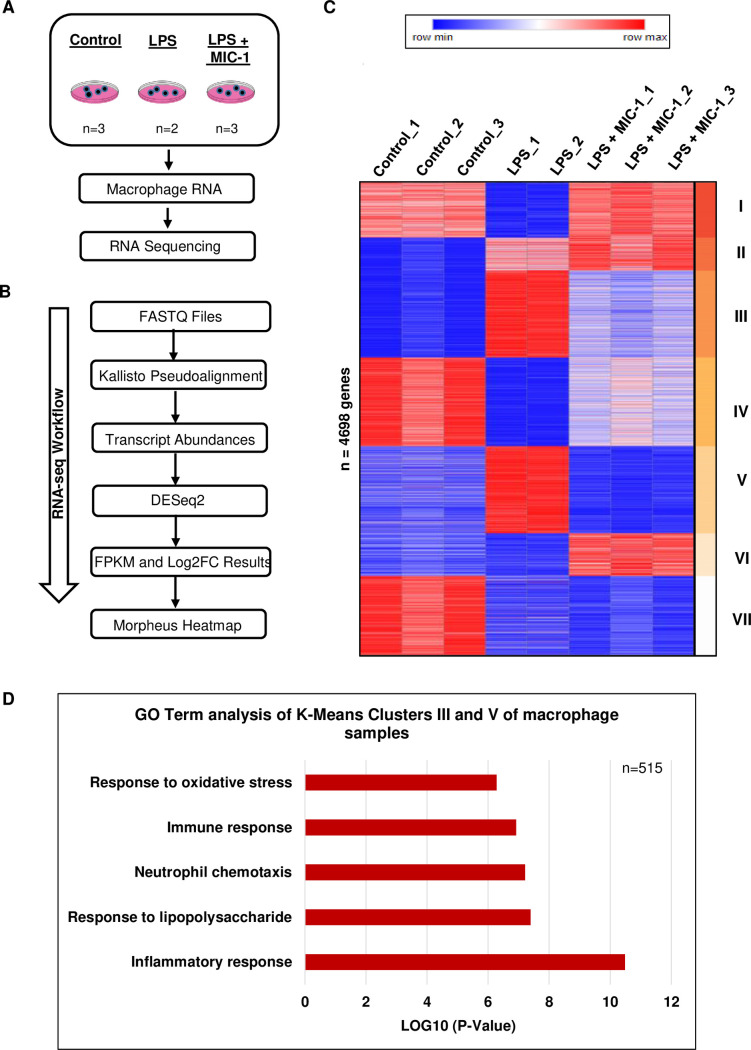
Transcriptome analysis of RAW264.7 murine macrophages.(A) Schematic workflow of RNA sequencing with control, lipopolysaccharide (LPS), LPS+10 μM MIC-1 samples. (B) RNA-seq workflow of transcriptome analysis on Raw 264.7 macrophages. (C) Transcript abundances were obtained from eight Raw 264.7 mouse macrophage samples with three control replicates, two LPS replicates, and three LPS replicates treated with 10 μM of MIC-1. DESeq2 v1.20.0 was used to generate Log2FC values of the following treatments using the transcript abundances: control vs. LPS, control vs. LPS+10 μM MIC-1, and LPS vs. LPS+10μM MIC-1. An FPKM table was outputted with the intersection, removing duplicates, of genes filtered for the absolute value of Log2FC > 1, average FPKM value per gene > 1, and adjusted P-value < 0.01 from the three aforementioned Log2FC comparisons. Using Morpheus, a heat mapping software provided by the Harvard Broad Institute, seven k-means clusters were obtained from the gene list of 4,698 genes based on the same FPKM table adjusted through z-score standardization and Euclidean distance correlation. (D) Gene ontology analysis using DAVID v6.8 functional annotations (biological process) was conducted on genes (n = 515) from k-means clusters III and V of the heatmap in Fig 1C.